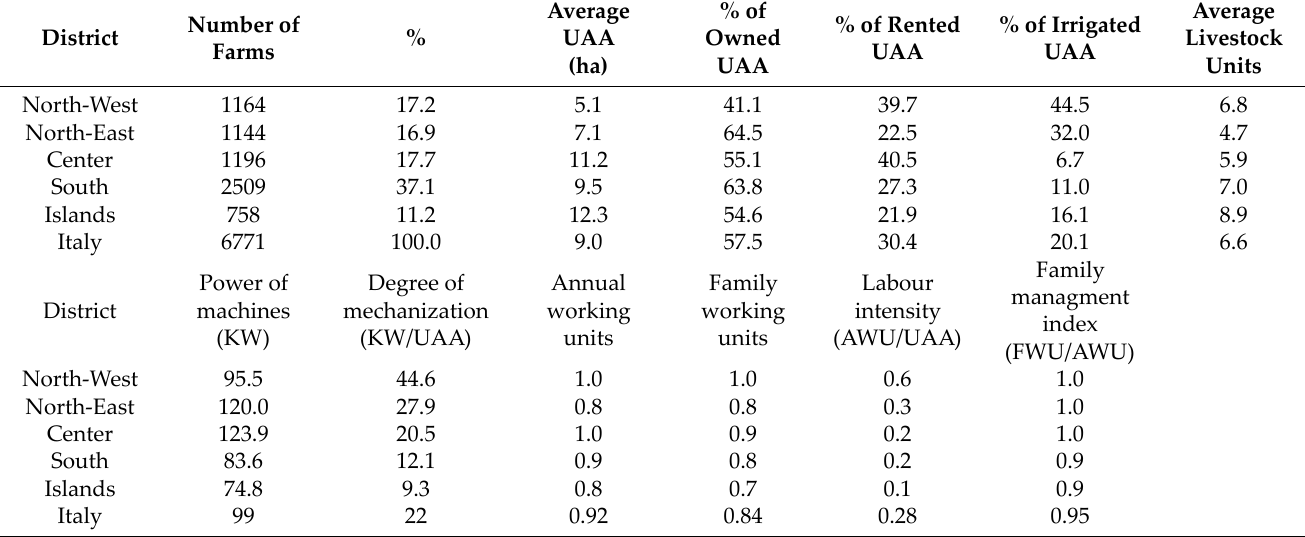
Table 2. Distribution of small farms by district and values of the main structural